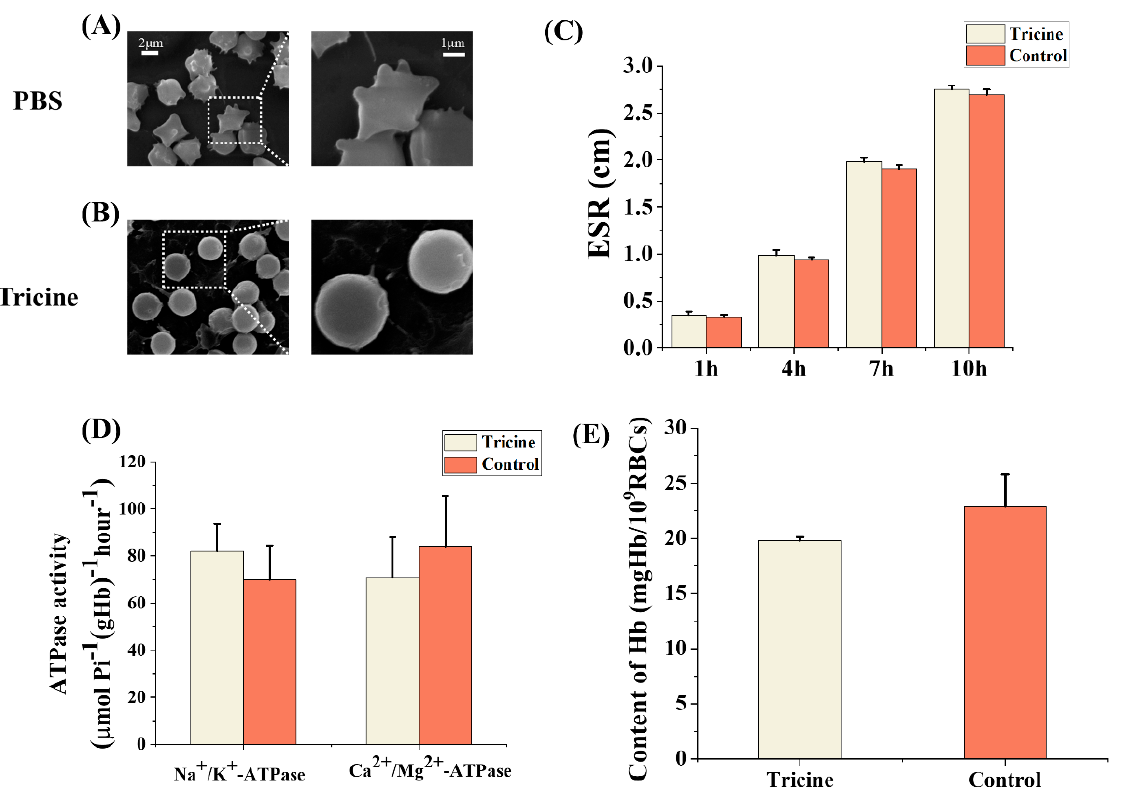
Figure 6. The properties of RBCs after cryopreservation. The representative thawed RBCs’ morphologies when cryopreserved in PBS ( A ) and tricine ( B ). The ESR ( C ), ATPase activities ( D ) and content of Hb ( E ) of thawed RBCs in the control group and tricine group. The concentration of tricine was 6%wt in all experiments. The control group comprised the fresh RBCs without cryopreservation. Three replicates of each sample were tested and the data are shown as mean ± SD. ESR = erythrocyte sedimentation rate. Hb = hemoglobin.